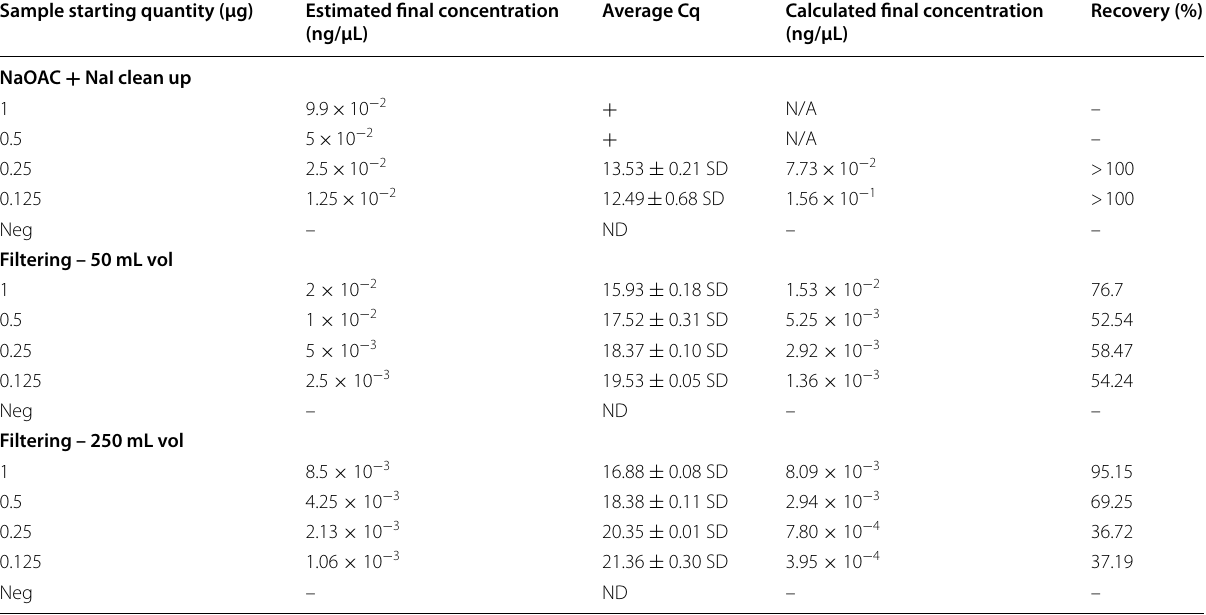
Table 3 Moat water samples spiked with varying starting quantities of A. tomentosa DNA for environmental DNA isolation methods, estimated final concentrations, and their respective average Cq values and SD, used to calculate actual final concentrations of DNA in each sample used to assess DNA recovery from each method used Sample starting quantity